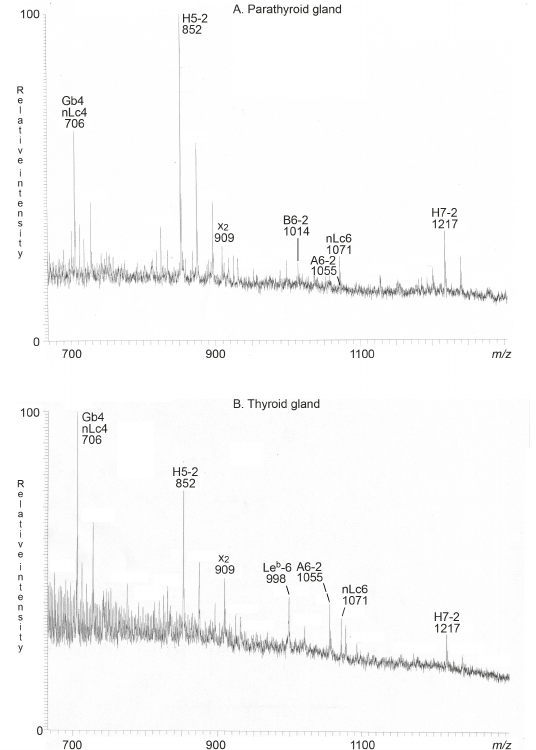
Figure 3. LC-ESI/MS of the oligosaccharides obtained from the total non-acid glycosph- ingolipid fractions from human parathyroid and thyroid glands by hydrolysis with endo- glycoceramidase II from Rhodococcus spp. ( A ) Molecular ion profile from LC-ESI/MS of the oligosaccharides from human parathyroid glands. ( B ) Molecular ion profile from LC- ESI/MS of the oligosaccharides from human thyroid glands. The identification of oligosac- charides was based on their retention times, determined molecular masses, and subse- quent MS 2 sequencing. The oligosaccharides identified in the chromatograms were: Gb4, GalNAc β 3Gal α 4Gal β 4Glc; nLc4, Gal β 4GlcNAc β 3Gal β 4Glc; H5-2, Fuc α 2Gal β 4GlcNAc β 3Gal β